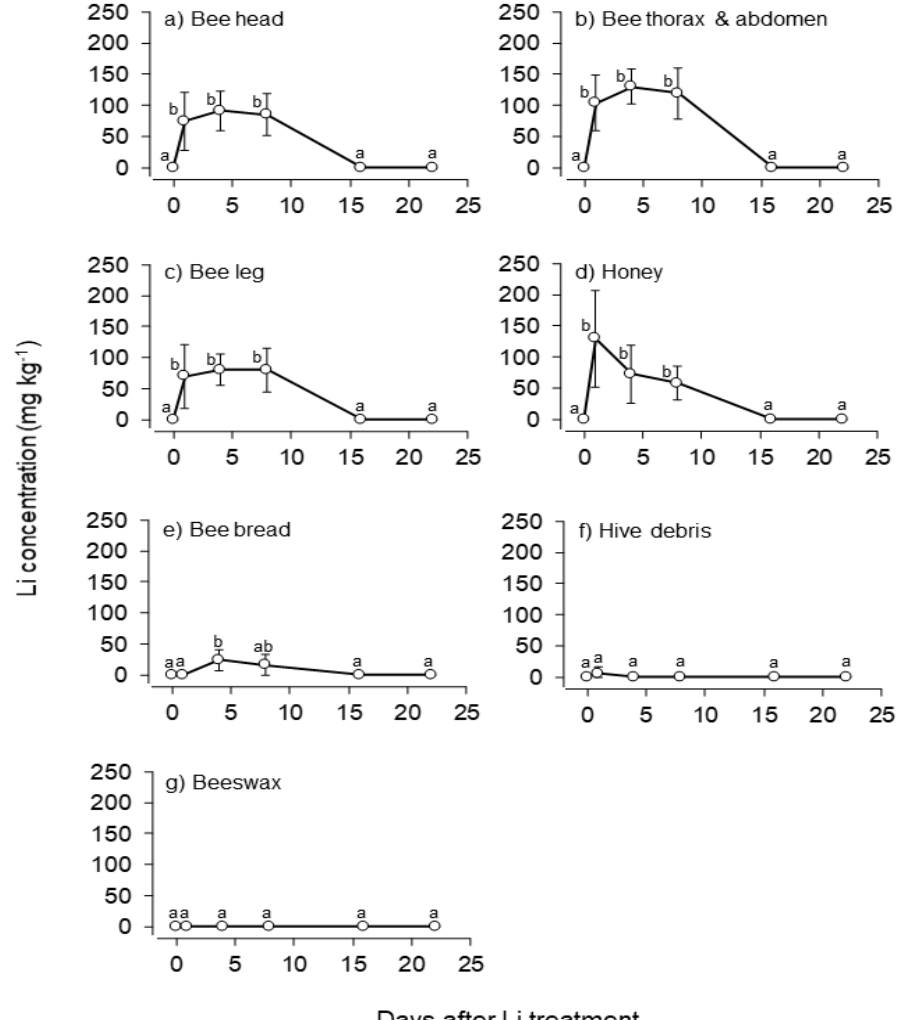
Figure 2. Post-treatment changes in lithium concentration in hive products and bees. Linear mixed model analysis (LMM) revealed a significant increase in Li concentrations (mean ± SD) in bee head ( a ), thorax and abdomen ( b ), and leg ( c ), as well as in honey ( d ) between 1 and 8 days after LiCl treatment, followed by a return of concentrations to the control level after 16 days post-treatment. Only a small increase in Li concentration was revealed in bee bread ( e ), and only on the 4th day post-treatment, and no increase in Li concentration at all was detected in hive debris ( f ) or beeswax ( g ). For LMM statistics, see Table 2. Plotted values not sharing any index letter are statistically different at p < 0.05 (Tukey HSD post hoc test). Note that the threshold of detecting Li was 0.0003 mg kg − 1 .